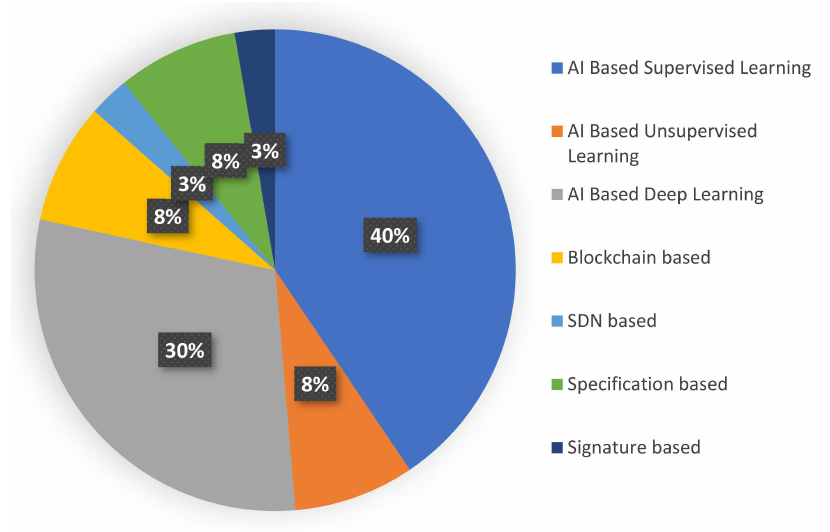
Figure 11. Number of selected studies per detection